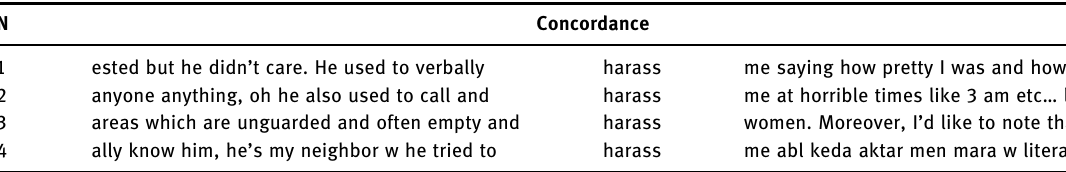
Table 33: Concordance lines for harass